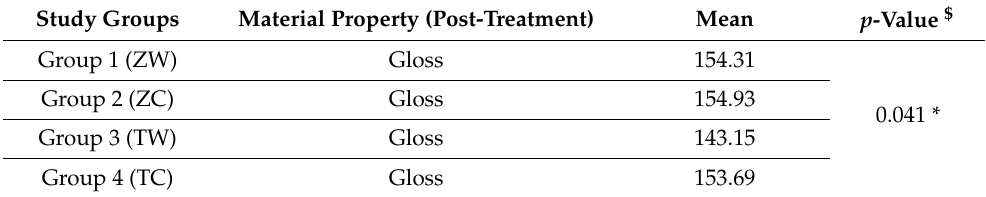
Table 7. Comparison of post-treatment surface gloss among study groups.